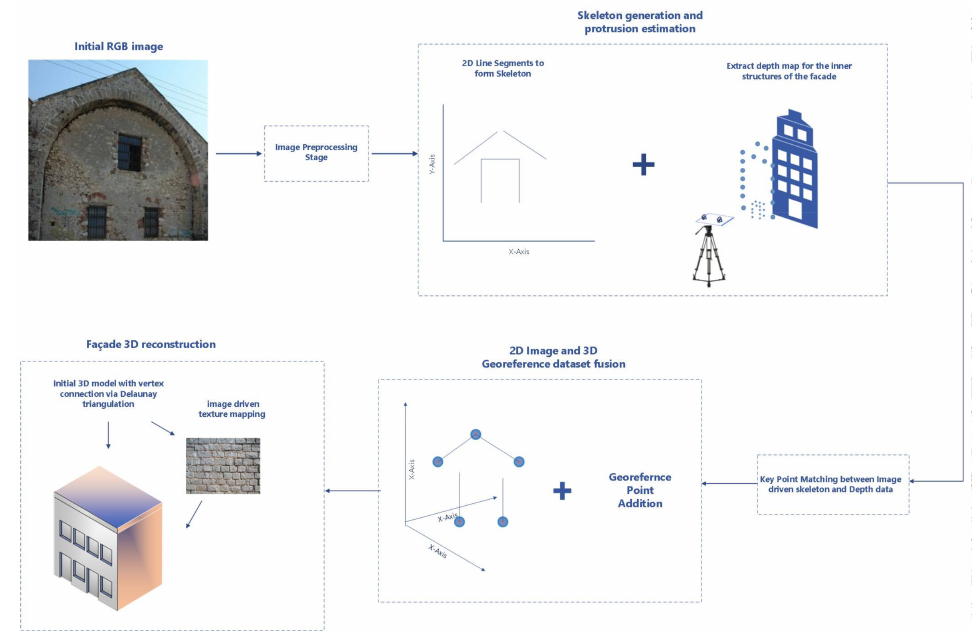
Figure 1. The 3D structure reconstruction scheme that is followed in the proposed method. The output is a detailed realistic 3D reconstruction of the façade of a building. Reconstructing the entire 3D model of the structure would require an additional 3D model stitching stage (a brief overview on this is presented in Section 4), which exceeds the goal of this